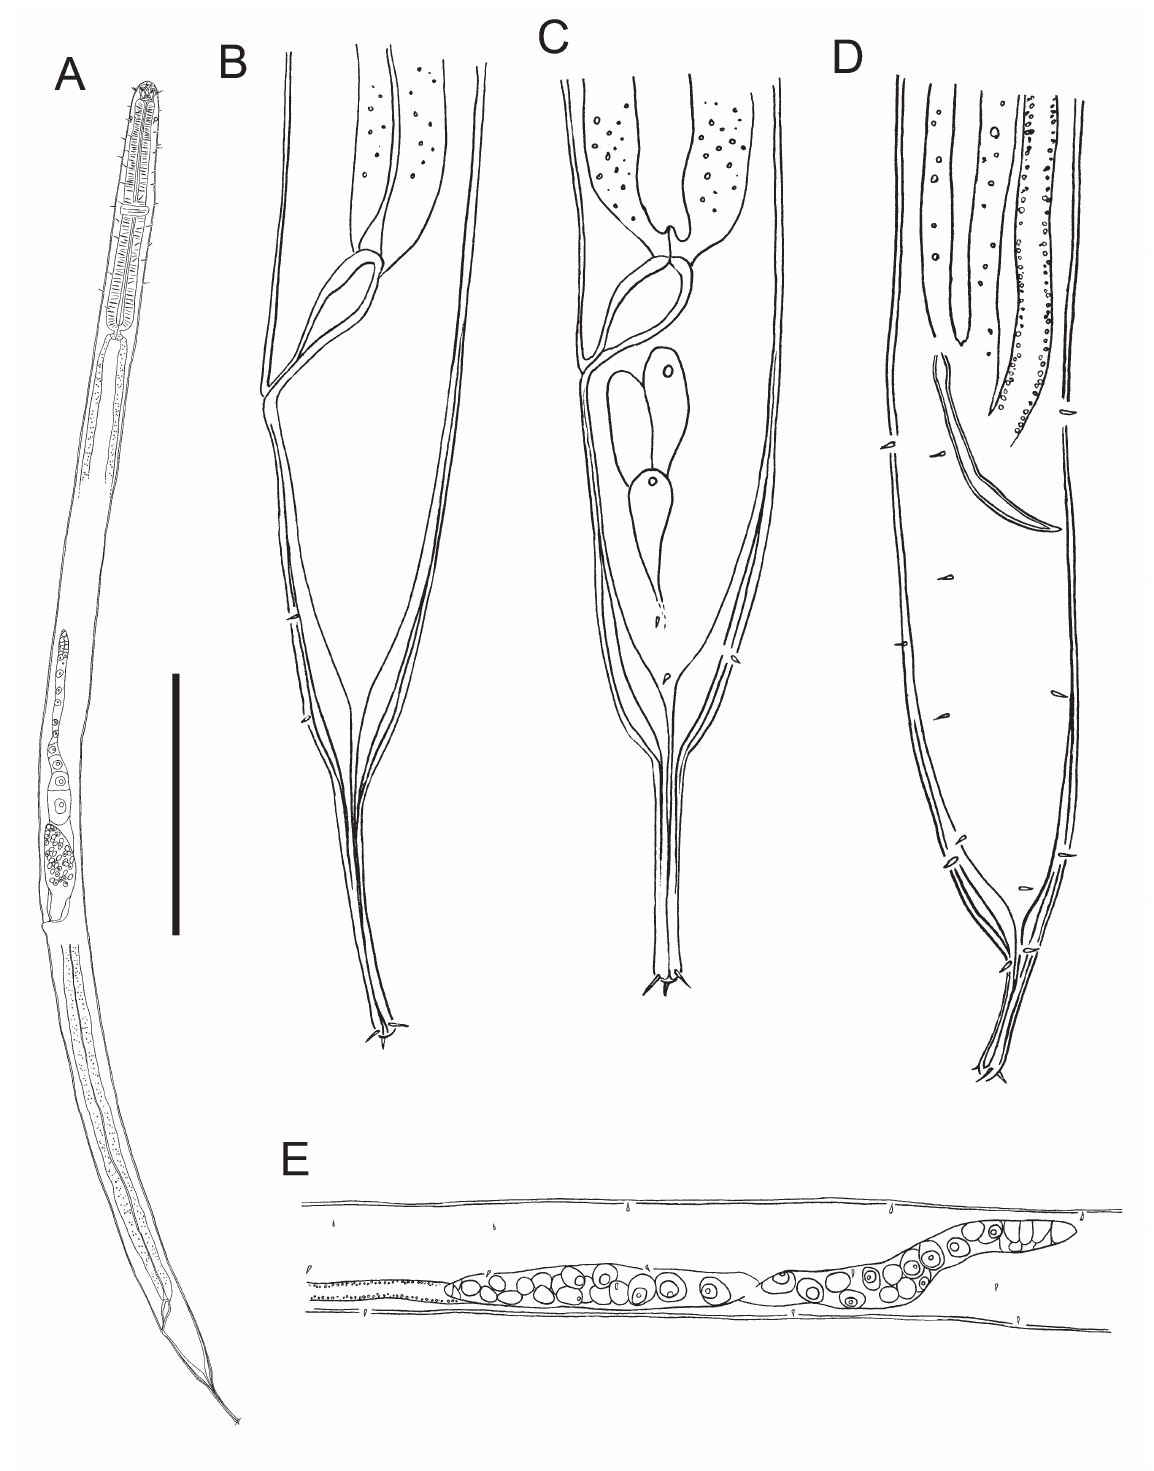
Fig. 5. Metasphaerolaimus constrictus sp. nov. A . Entire ♀. B–C . Female posterior body region. D . Male posterior body region. E . Male gonads. Scale bar: A = 300 µm; B–c = 55 µm; D = 45 mm; e = 80